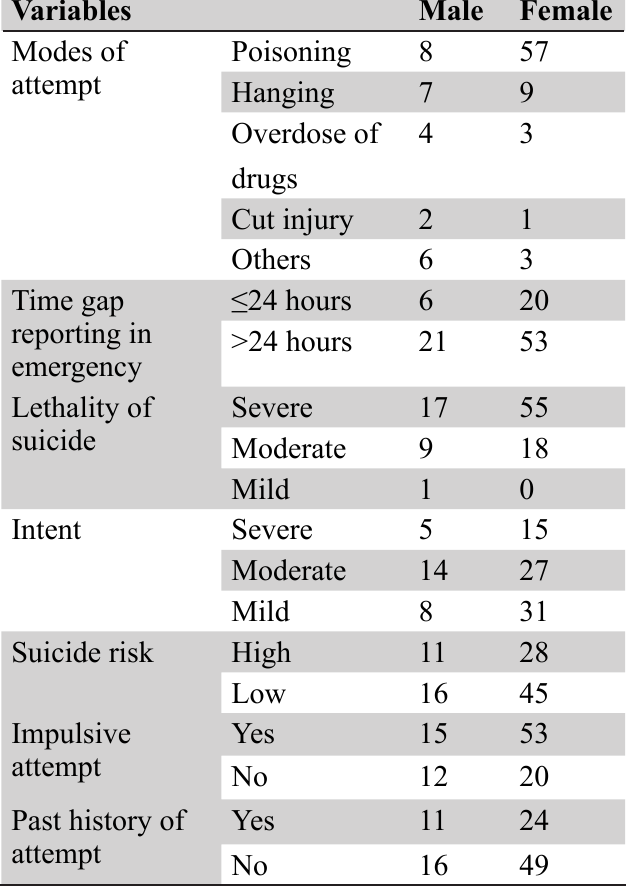
Table 2. Details of the intentional self harm /related to index suicidal attempt (N=100).